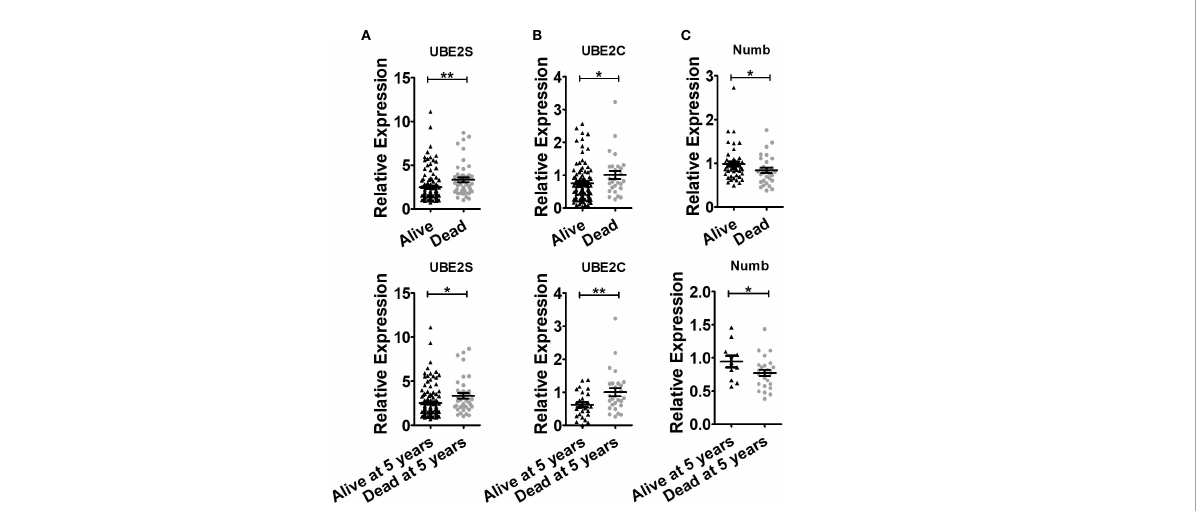
FIGURE 5 Breast cancer patients with shorter lifespans have higher levels of UBE2S and UBE2C and lower expression of Numb. (A) UBE2S mRNA expression in the Oncomine database of Pawitan Breast grouped by overall survival status (Up, Alive n = 113, Dead n = 46) and survival status at 5 years (Bottom, Alive at 5 years n = 121, Dead at 5 years n = 38). (B) UBE2C mRNA expression in Oncomine database of Esserman Breast grouped by overall survival status (Up, Alive n = 98, Dead n = 27) and survival status at 5 years (Bottom, Alive at 5 years n = 27, Dead at 5 years n = 27). (C) Numb mRNA expression in the